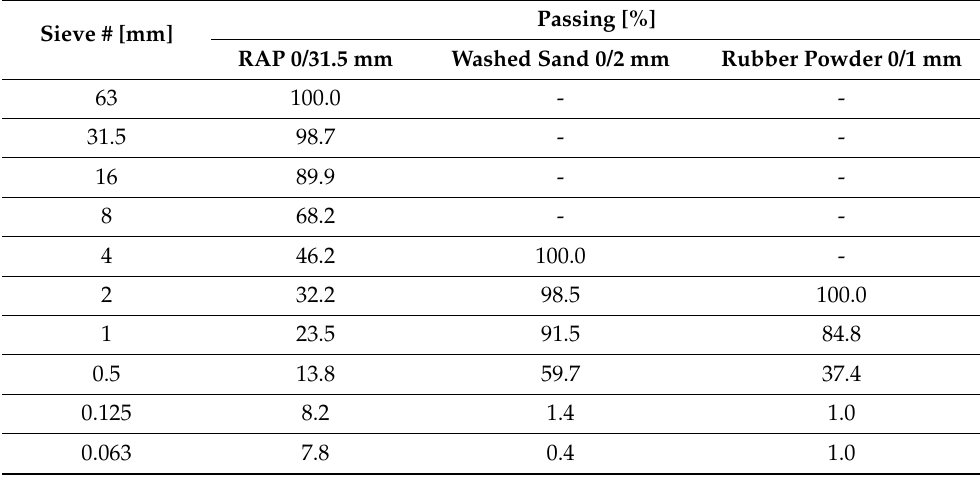
Table 1. Grading of constituent